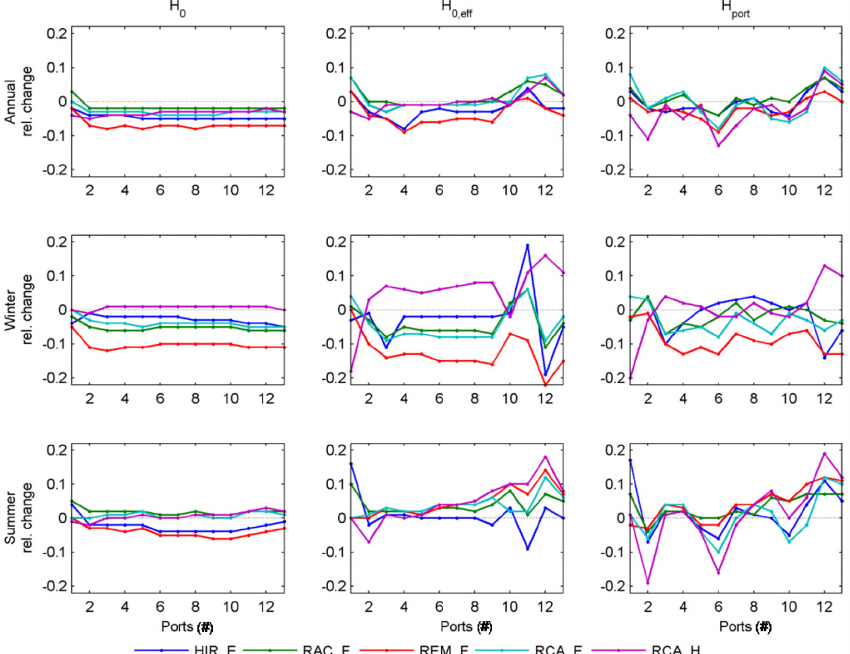
Figure 5. Projected relative changes (future minus present expressed as a decimal) for the: offshore H s (a, d, g) , offshore H s only accounting for the effective wave directions affecting each harbor (b, e, h) and the spatial averaged H s inside the harbor (c, f, i) . From top to bottom panels: annual analysis (a, b, c) , winter analysis (d, e, f) , summer analysis (g, h, i)